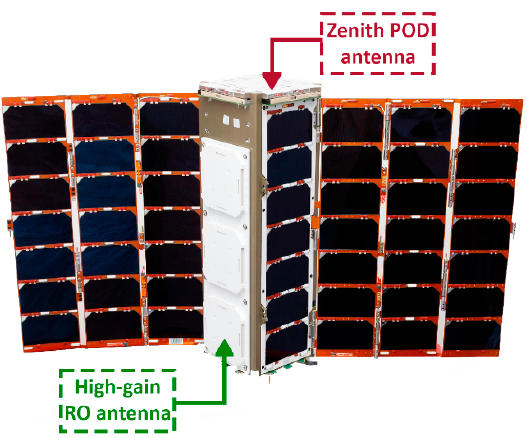
Figure 1. Structure of the Spire 3U RO CubeSat (source: Spire Global, Inc.). The required observation segments, attitude information, and phase center values of the CubeSats are provided by Spire Global, Inc. Each observation segment contains from 45 min to 3 h, mostly around 1.5 h, dual-frequency GPS observations collected by the zenith POD antenna of the CubeSats (see Figure 1). Figure 2 shows the MDEV of the estimated clocks for different averaging times between 1 s and 1.5 h that are computed from Equation (3). The stability of the clock errors varies between 10 − 11 and 10 − 3 , with about 95% of the computed MDEV being in the 10 − 8 to 10 − 4 range.